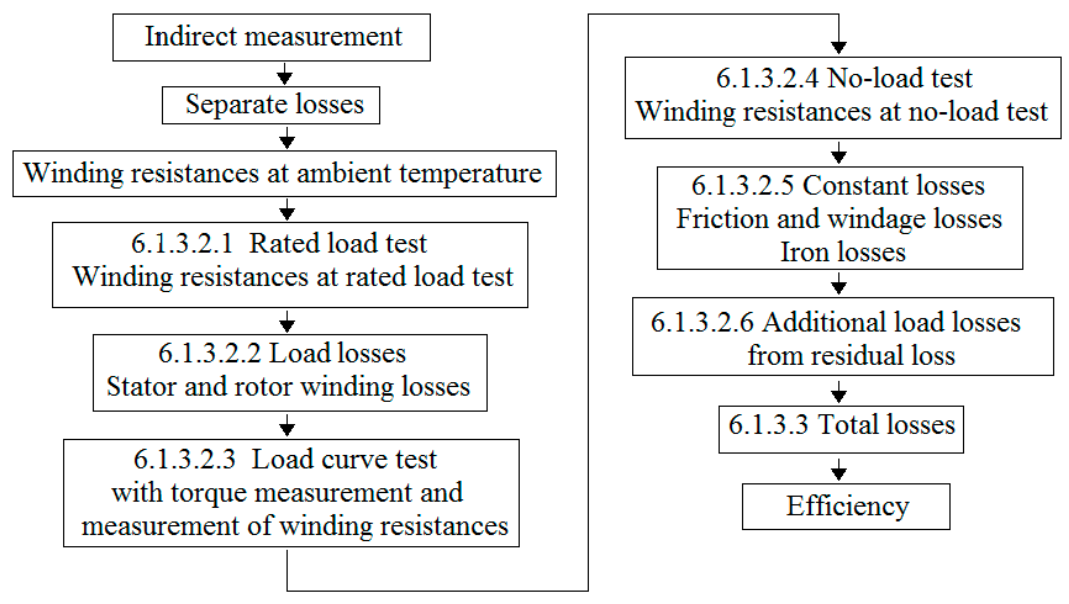
Figure 1. The procedure for the indirect evaluation of efficiency, with the measurement of total losses; the numbering refers to the paragraphs of IEC 60034-2-1 in which the tests are described.